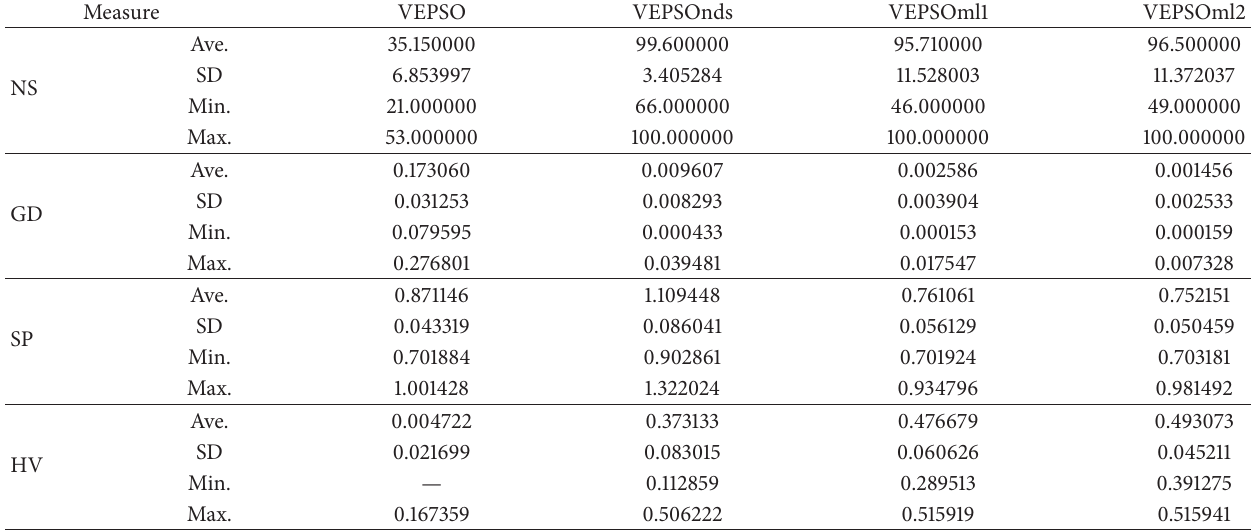
Table 4: Algorithm performance tested on ZDT3 problem.